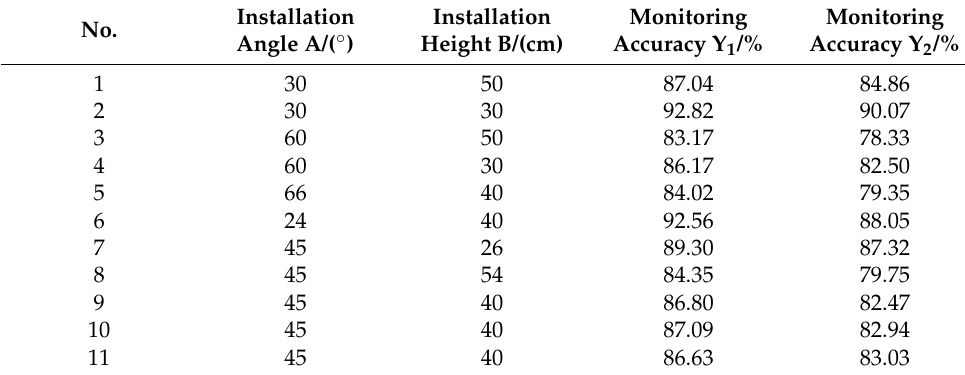
Table 5. Design of experiment and test